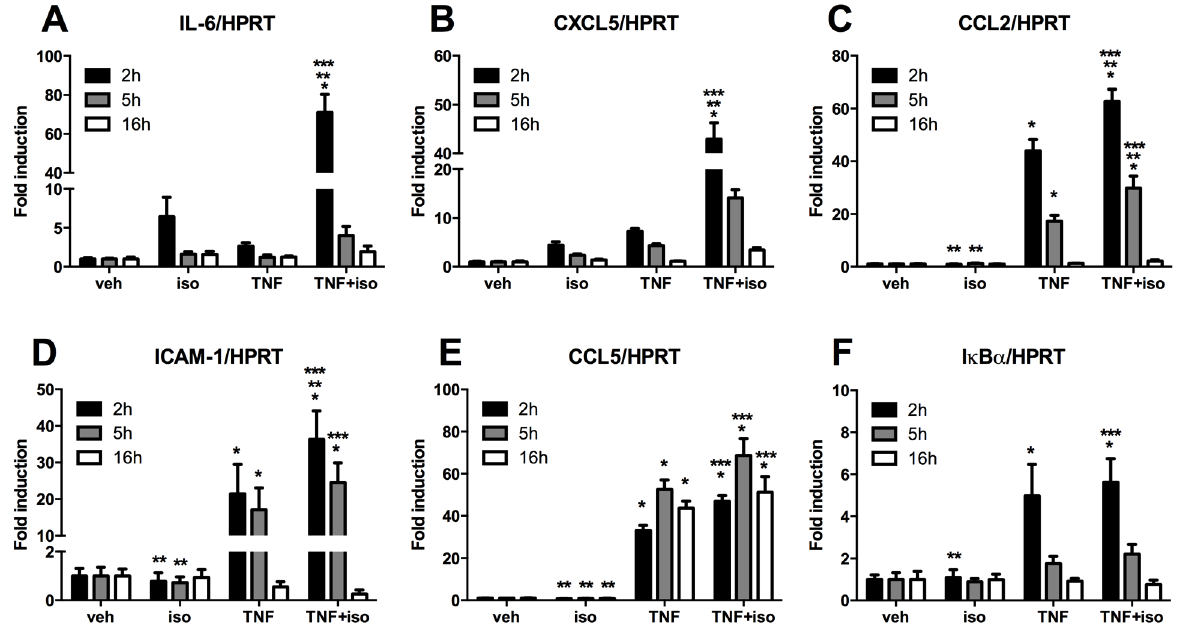
Figure 2. Effect of isoproterenol/TNF- a cotreatment on NF- k B-dependent gene expression in C2C12 myotubes. Expression of inflammatory markers was measured by RT-qPCR after 2, 5 and 16-hours induction with vehicle (veh), isoproterenol (iso) and/or TNF- a (TNF) in C2C12 myotubes. Fold induction for each gene was calculated versus veh control at the corresponding time point. Results represent average 6 SD of three independent experiments. Statistical significance was determined via ANOVA followed by Bonferroni’s multiple comparison test. (*) Significantly different from veh. (**) Significantly different from TNF. (***) Significantly different from iso.